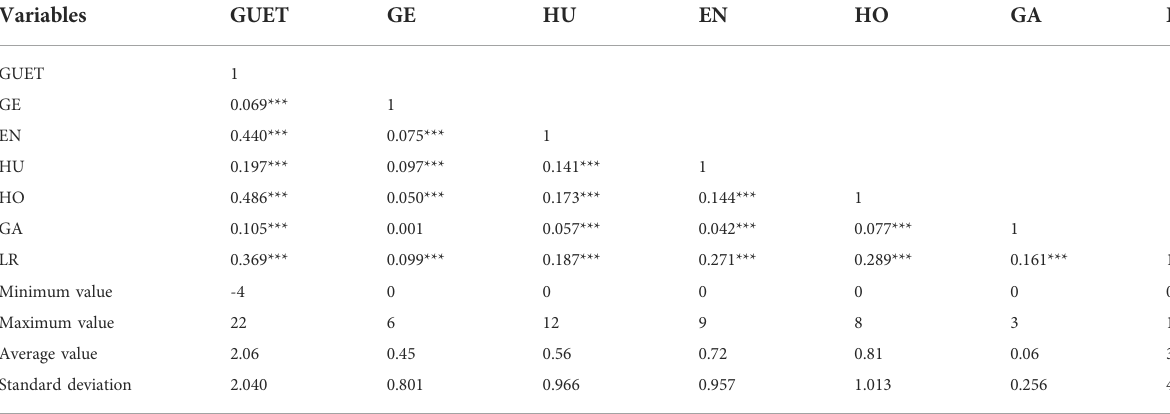
TABLE 4 Variable descriptive statistics and correlation coef fi cient analysis.